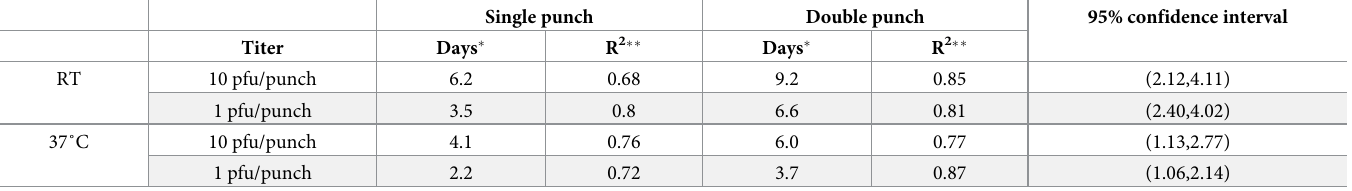
Table 1. Increased temperature decreases the duration of YFV RNA positivity when extracted from FTA cards. Single punch